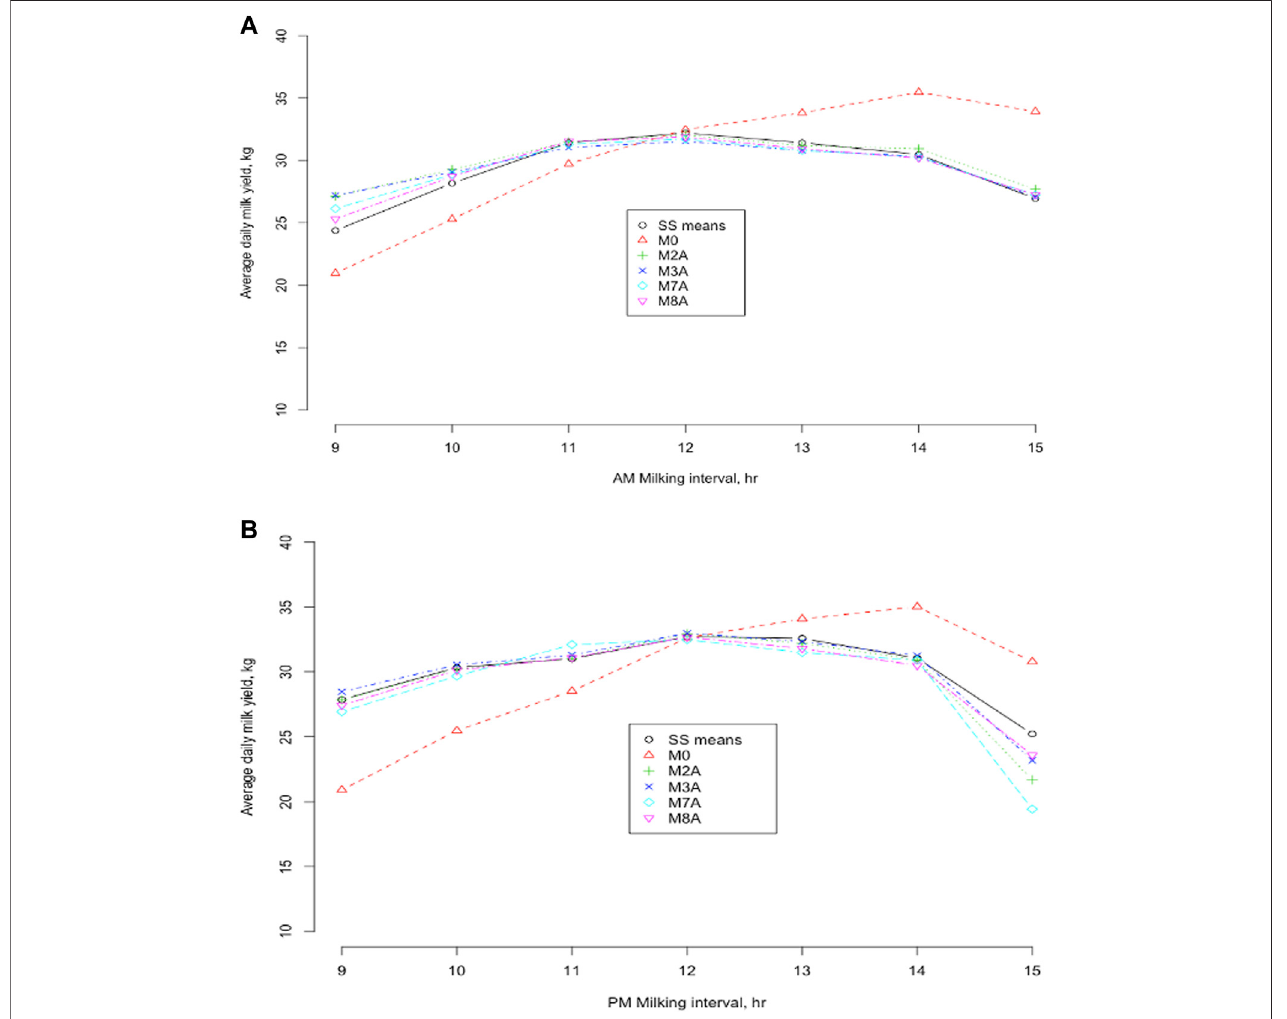
FIGURE 6 | Average daily milk yields were obtained from fi ve models and smooth spline (SS) means of the daily milk yield against morning (A) and evening (B) milking intervals from 9 to 15 h, respectively. M0 = daily milk yield (DMY) estimated as two times AM or PM yield; M2A = linear regression of the difference between morning (AM) and evening (PM) milk yields on milking interval and days in milk (DIM); M3A = linear regression of DMY on the milking interval and DIM; M7A = linear regression of AM or PM proportion of DMY on milking interval and DIM (Wiggans, 1986); M8A = exponential regression model (Wu et al.,